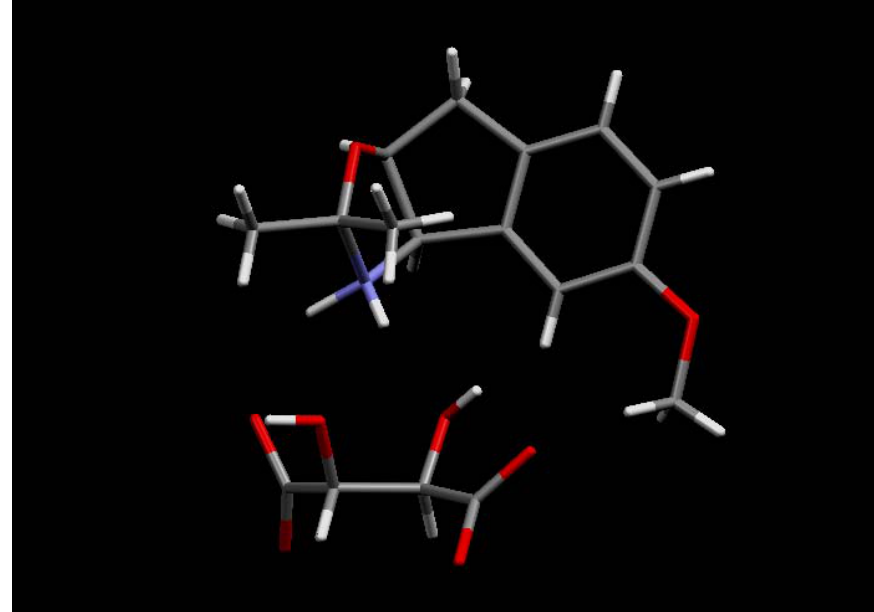
Figure 4. X-ray structure of ( R,R )-(+)-tartaric acid salt of 32